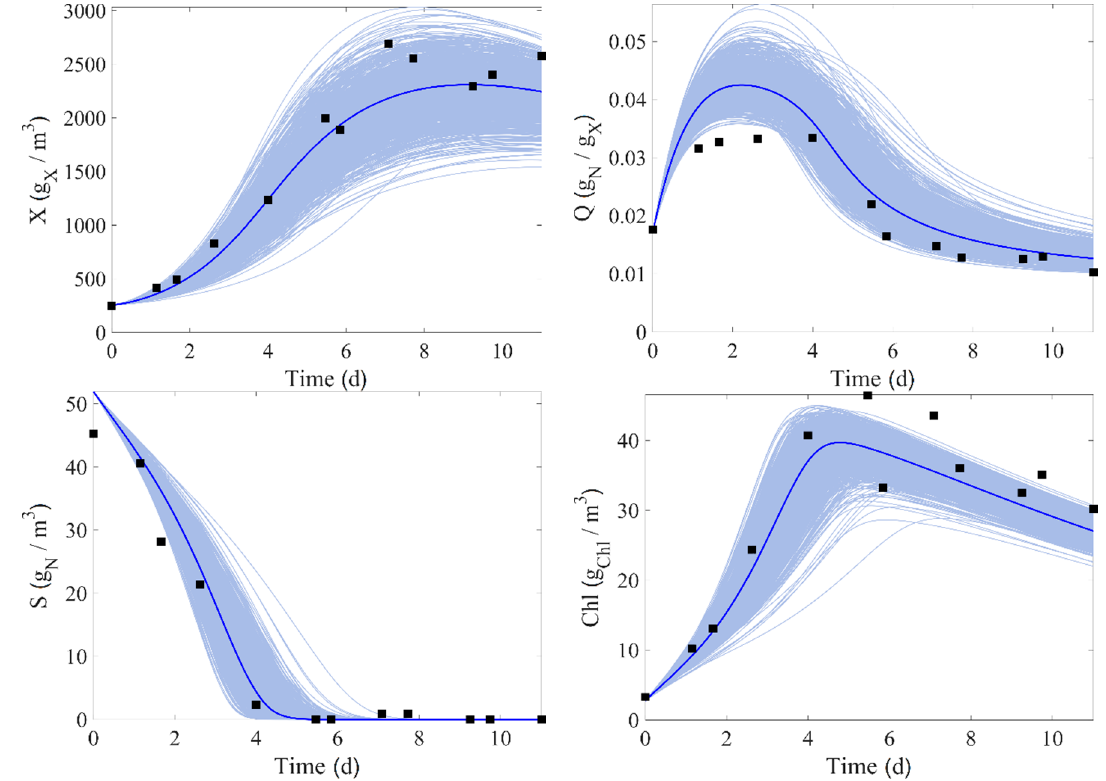
Figure 5. Validation test. Experimental data and model simulation for run 8.